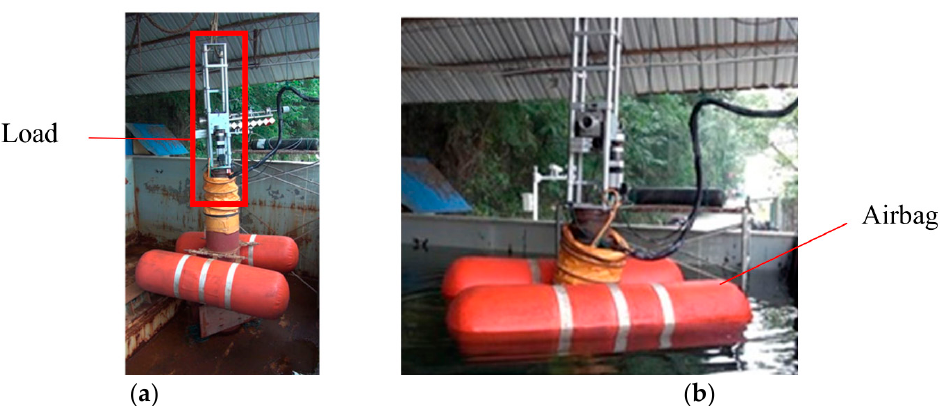
Figure 14. Drifting platform setup for the water surface stabilization experiment. ( a ) Empty water pool, ( b ) Full water pool.